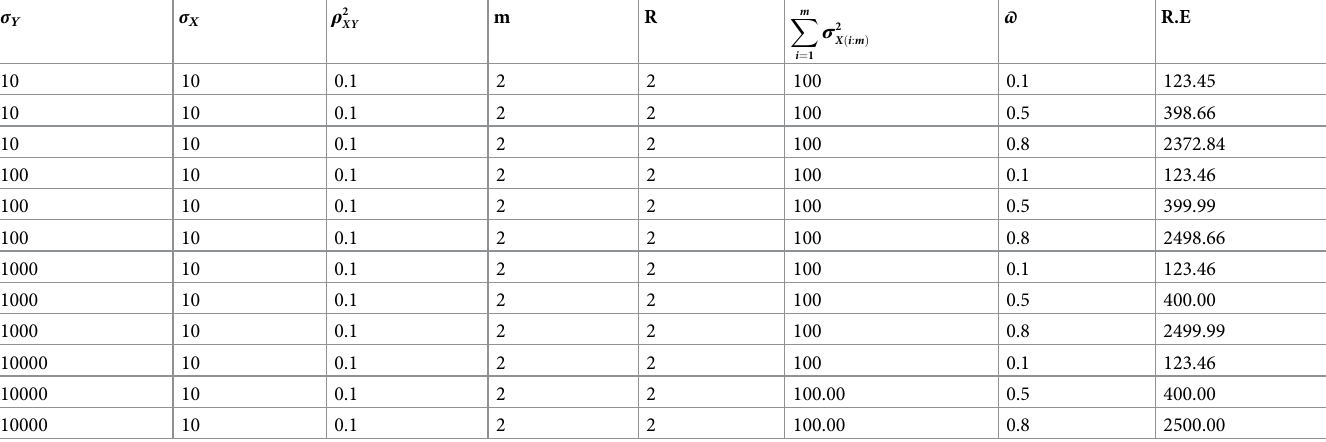
in comparison to ^ μ NGO : Disclosures